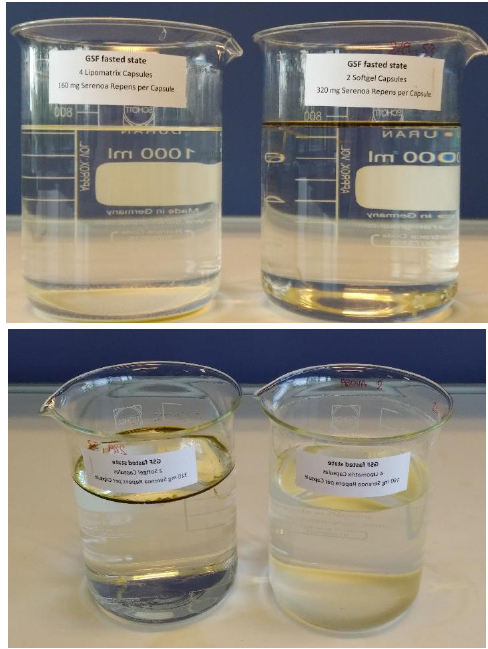
Figure 3. Visual comparison of the liquids coming from disaggregation test in GSF between Lipomatrix containing SRO (left beaker) and soft-gel SRO contained in two soft-gel capsules (right beaker). It is clearly appreciable the presence of an oily layer of SRO in the right beaker relating to the soft-gel capsules and the absence of the oily layer in the surface of the GSF liquid relating to Lipomatrix powder.